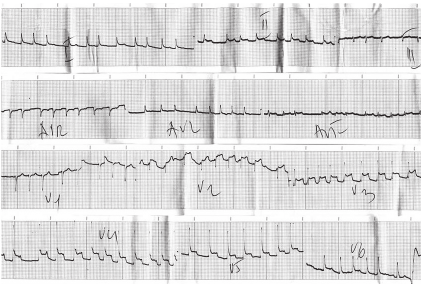
Figure 1: ECG shows signs of absolute arrhythmia, HR of 140/min, and ST elevation from V2 to V6, D1 and D2.